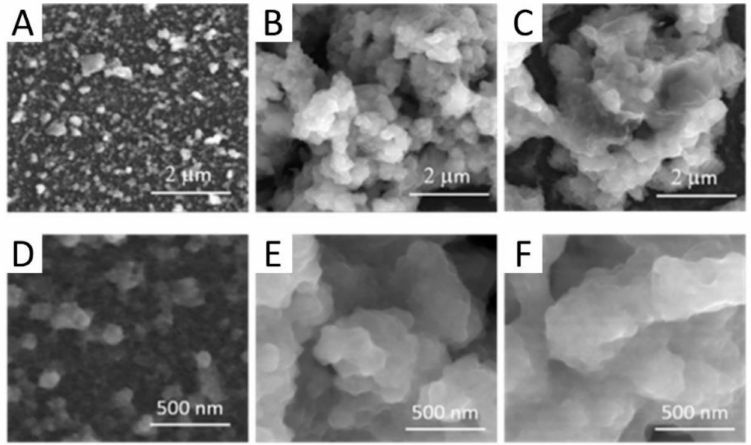
Figure 6. ( A ) SEM images of IrO x -eG hybrid showing the millfeuille nanostructure. (inset: macro scale showing the large homogeneity of the coating). ( B ) Crack developed under the SEM electron beam with millfeuille ordering. (Inset showing secondary electrons image, where carbon is not seen vs iridium) [24]. With permission from Elsevier.